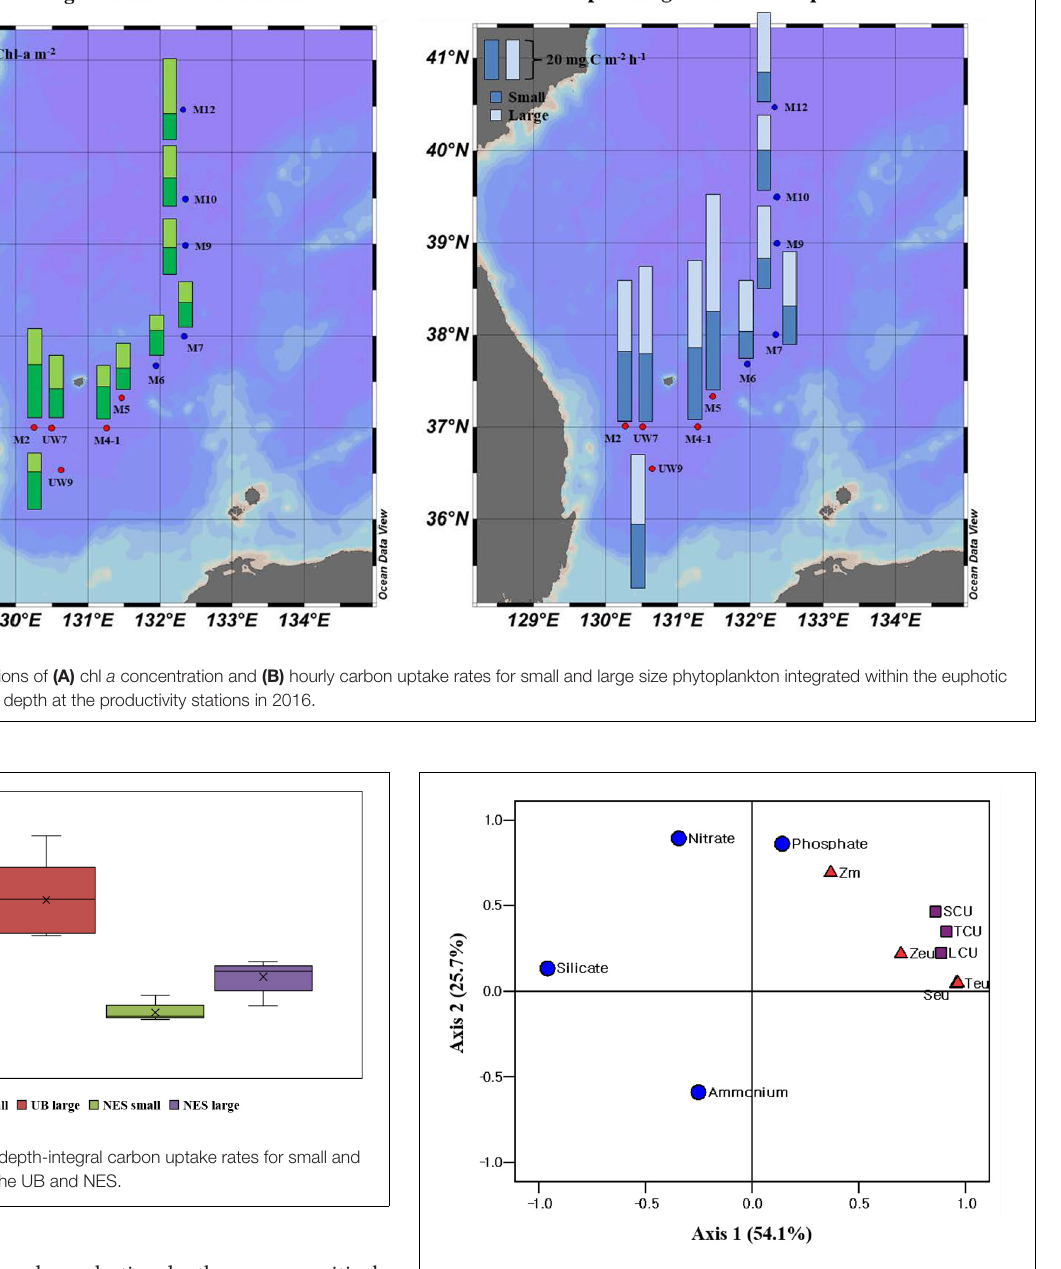
FIGURE 7 | Principle component analysis (PCA) ordination plots of axes 1 and 2 showing carbon uptake rate of different size phytoplankton in relation to environmental variables in the western EJS during the 2016 cruise. T eu , water temperature averaged over the depth of the euphotic zone (Z eu ); S eu , salinity averaged over Z eu ; Z m , mixed layer depth; TCU, total carbon uptake rate; SCU, small carbon uptake rate; LCU, large carbon uptake